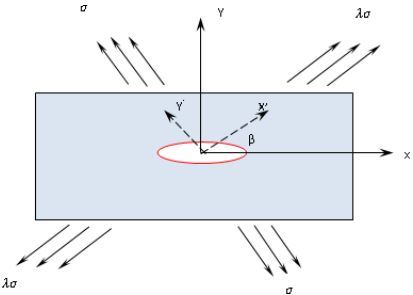
Figure 1: Infinite plate with elliptical shape cutout subjected to in plane loading